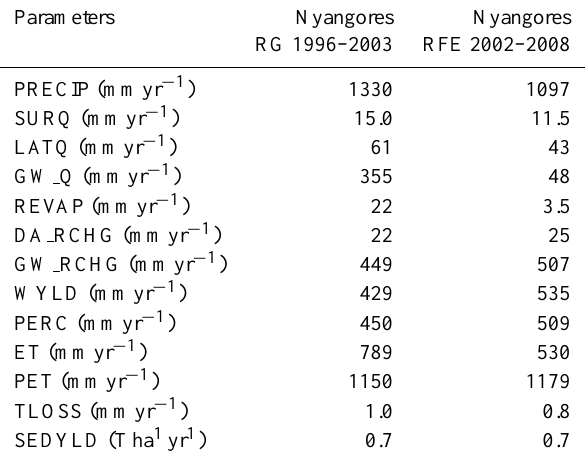
Table 8. Annual average water balance components for the cali- brated Nyangores sub-basin models.